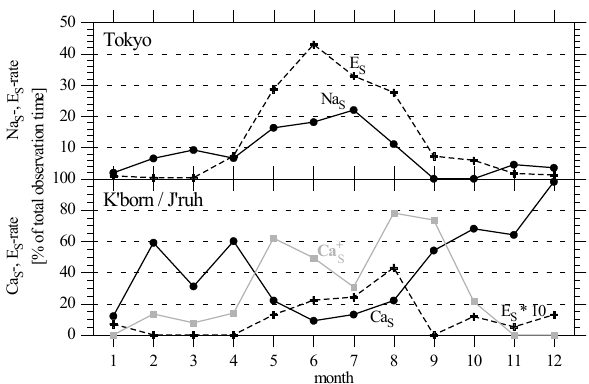
Fig. 11. Seasonal variation of sporadic metal and electron layers: Na s and E s as observed above Tokyo (Nagasawa and Abo, 1995) (upper panel), Ca s and E s as observed above K¨uhlungsborn and Juliusruh, respectively (lower panel). The occurrence of strong spo- radic Ca + s with number densities higher than 300 cm − 3 is shown for comparison (lower